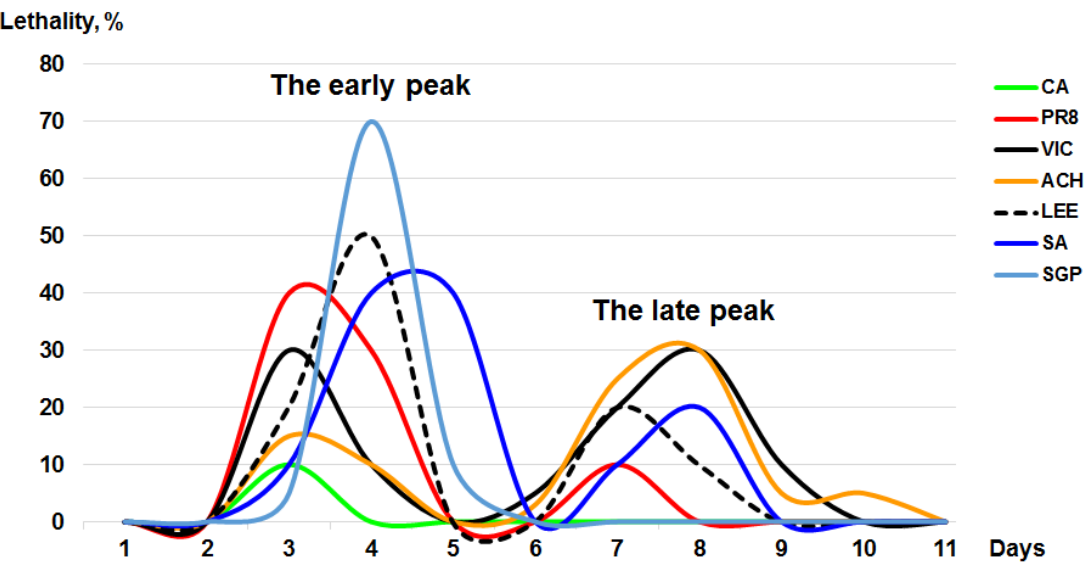
Figure 3. Lethality of the influenza viruses for the BALB/c mice. The mice were inoculated with a massive dose of influenza virus (8.0–9.0 log 10 EID 50 /mL).